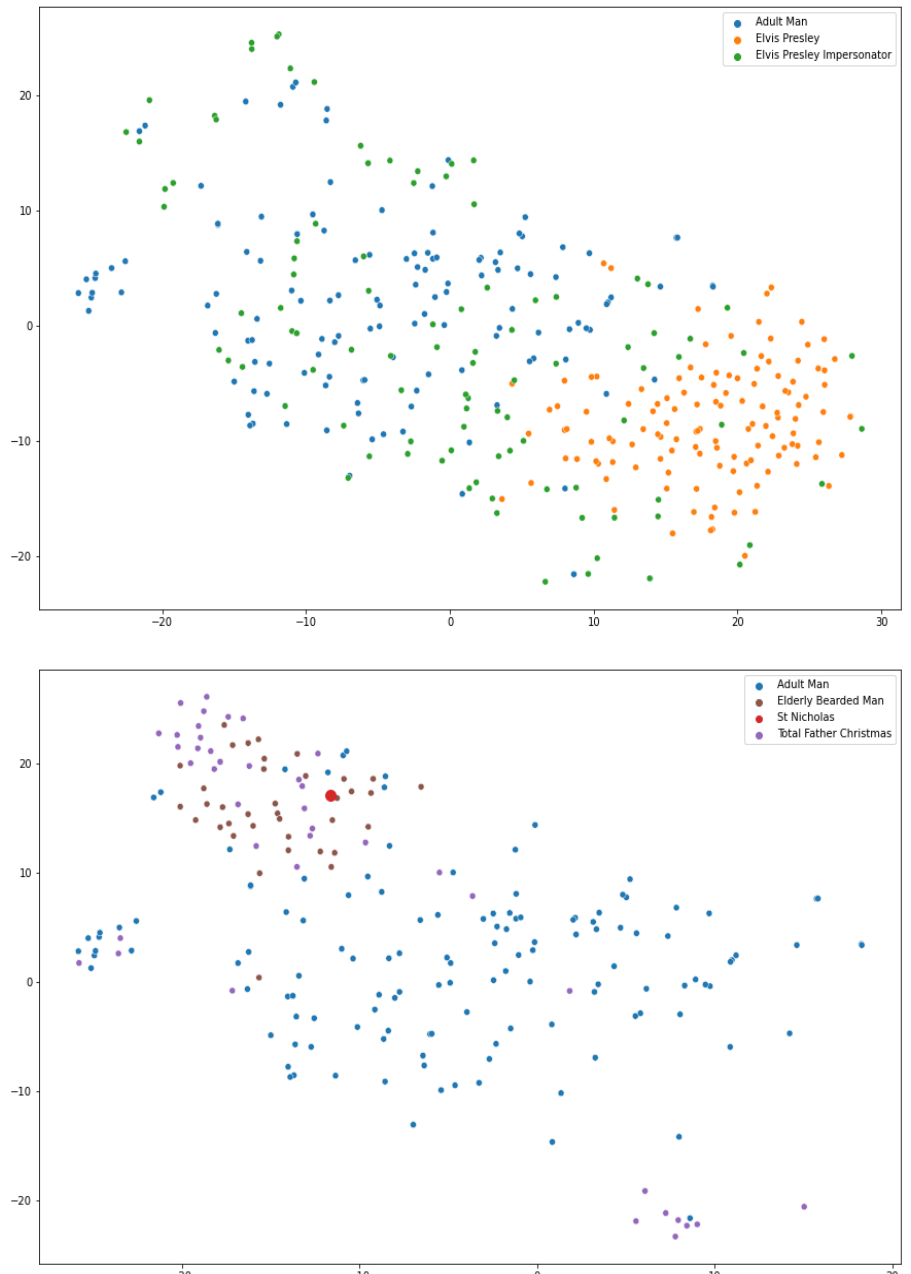
Figure 3. Visual representation* of the distribution of the facial feature vectors. Upper Panel: Adult Man (blue circles), Elvis Presley (orange circles), and Elvis Presley Impersonator (green circles) groups. Lower Panel: Adult Man (blue circles), Elderly Bearded Man (brown circles), and Total Father Christmas (purple circles) groups. The facial feature vector of Face Lab’s Saint Nicholas is also presented (larger red circle). *The full 128-dimensional feature vectors generated by OpenFace are presented visually in this figure by reducing to 2-dimensional vectors using t-distributed stochastic neighbour embedding (t-SNE), as described in the methods section.